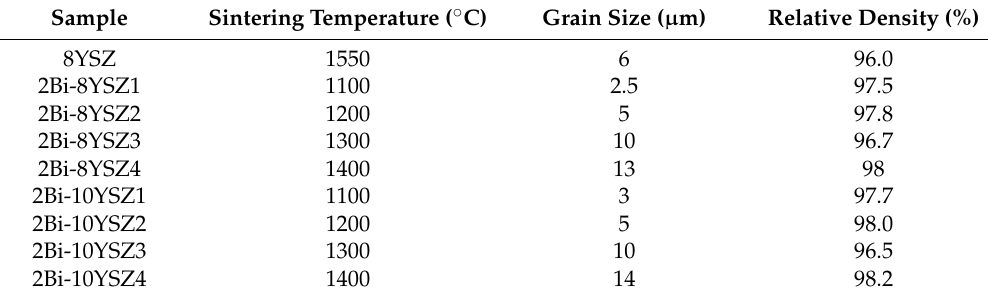
Figure 4. Scanning electron microscope images of 2Bi-10YSZ at various temperatures: ( a ) 1100 °C; Figure 4 is a scanning electron micrograph of 2Bi-10YSZ sintered at various temperatures. The image indicates that the 2Bi-10YZ sample has a more uniform morphology as well as fewer small Table 2. Grain size and densiy of